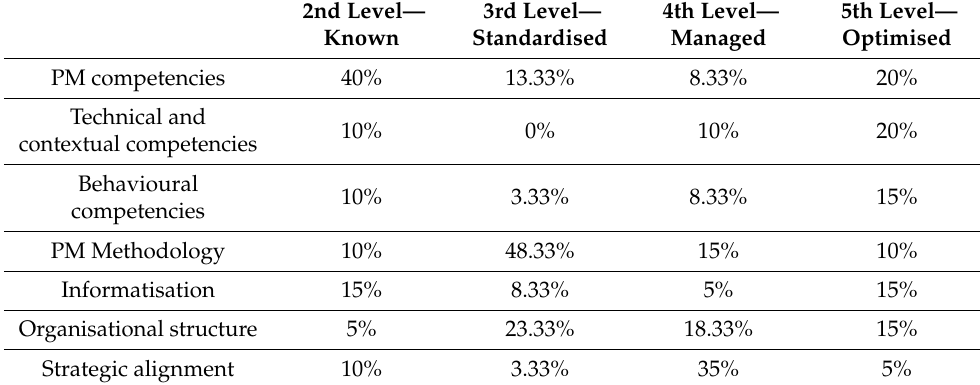
Table 3. Dimensions saturation by maturity level according to the original MMGP-Prado